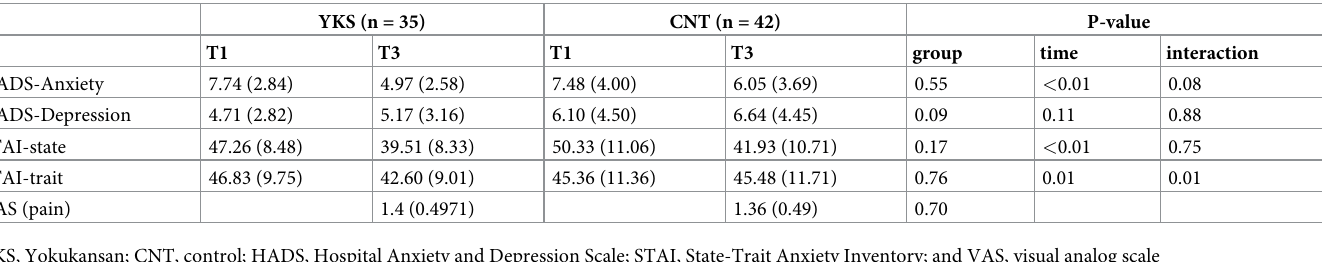
Table 2. Results of all